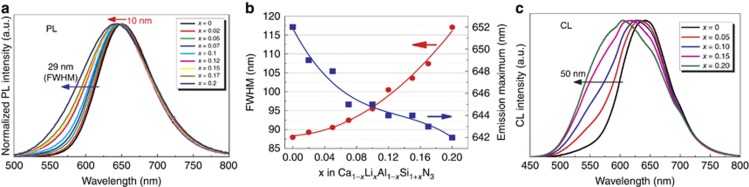
Emission spectra of Ca1−xLixAl1−xSi1+xN3 (1.0 mol% Eu2+). (a) Photoluminescence emission bands, (b) the FWHM and emission maximum and (c) cathodoluminescence spectra.